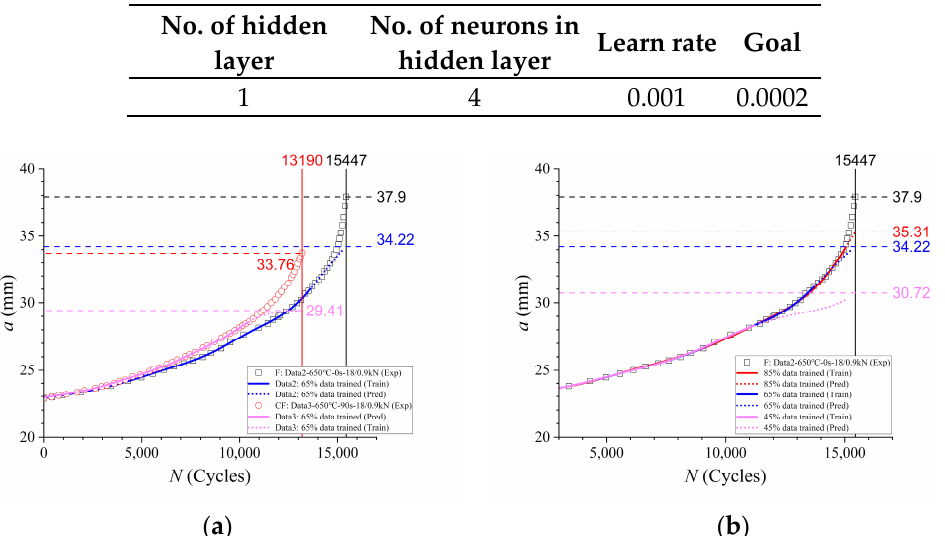
0.0002 Figure 11. a - N curves prediction using RNN and NNIL scheme for Data2 and Data3, respectively.